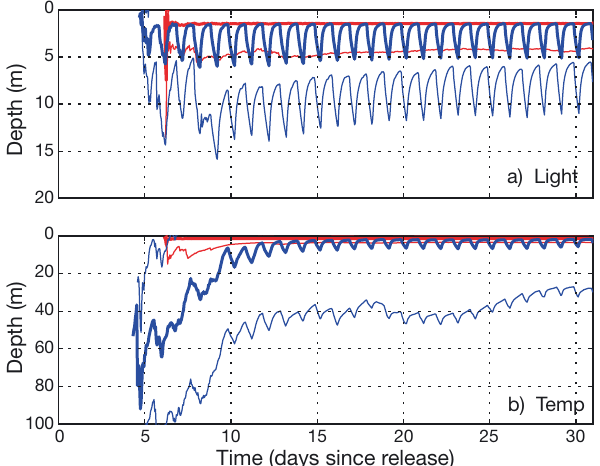
Fig. 9. Median depth (thick lines) ± 1 SD (thin lines) during the copepodite stages of simulated Lepeophtheirus salmonis during the simulation periods March (blue lines) and May (red lines) 2009 based on currents field from the model NorKyst800. All copepodites were swimming vertically de - pending on ambient light. (a) ‘Light’ (light-controlled) and (b) ‘Temp’ (temperature-controlled) denote the vertical be- haviour during the naupliar